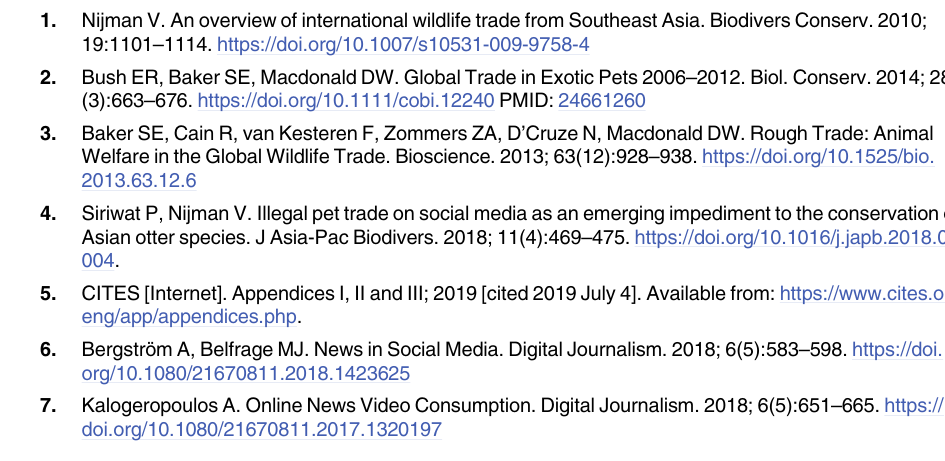
S2 Table. Number of comments across all wild cat and primate videos. The number and dis- tribution of comments extracted between May 2006 and October 2019 across all wild cat and primate videos included within the study. The number of comments associated with each video and each identifiable species varied. S3 Table. Popular videos within the study. The top ten most popular videos included within the study, according to view count at the time of data extraction, listed with primary species featured and additional video specifications. S1 Fig. YouTube 1 policy guidelines. Excerpts from YouTube 1 ’s “violent or graphic content” policy guidelines available online. The policy sections featured are those pertaining to the use of animals within